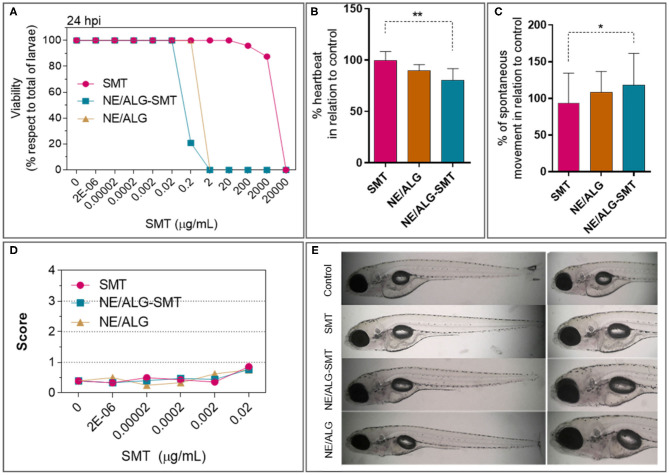
(A) Viability of zebrafish larvae after 24 h of exposure (hpi) to: sumatriptan in an aqueous solution (SMT), sumatriptan incorporated in the hybrid system (NE/ALG-SMT); control nanoemulsion without sumatriptan (NE/ALG). (B) Percentual variation of heart rate, in relation to control. (C) Percentual variation of spontaneous movement, compared to control. (D) Toxicological test: score of morphological changes after 24 hpi. (E) Representative images of the analyzed larvae after 24 hpi. Score: 0 = no changes; 1 = one to two morphological anomalies; 2 = three to four anomalies; 3 = more than four anomalies; and 4 = dead. Anova post-hoc Tukey test: *p < 0.05; **p < 0.01.